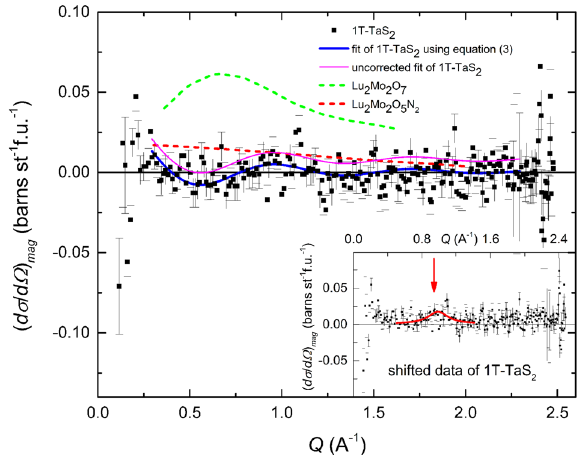
Fig. 2 The magnetic scattering cross section of 1T-TaS 2 at 1.5 K. The inset shows the shifted data (see the text for details) and the Lorentz fi t of the bump located at Q ~0.9 Å − 1 , while the main fi gure presents the original data together with the fi t and the data measured on the Lu 2 Mo 2 O 7 compound. Vertical error bars represent 1 σ s.d. counting statistics. (Fig. 2 shows the data of the Lu 2 Mo 2 O 7 compound taken from ref. 27 with permission. Copyrighted by the American Physical Society)